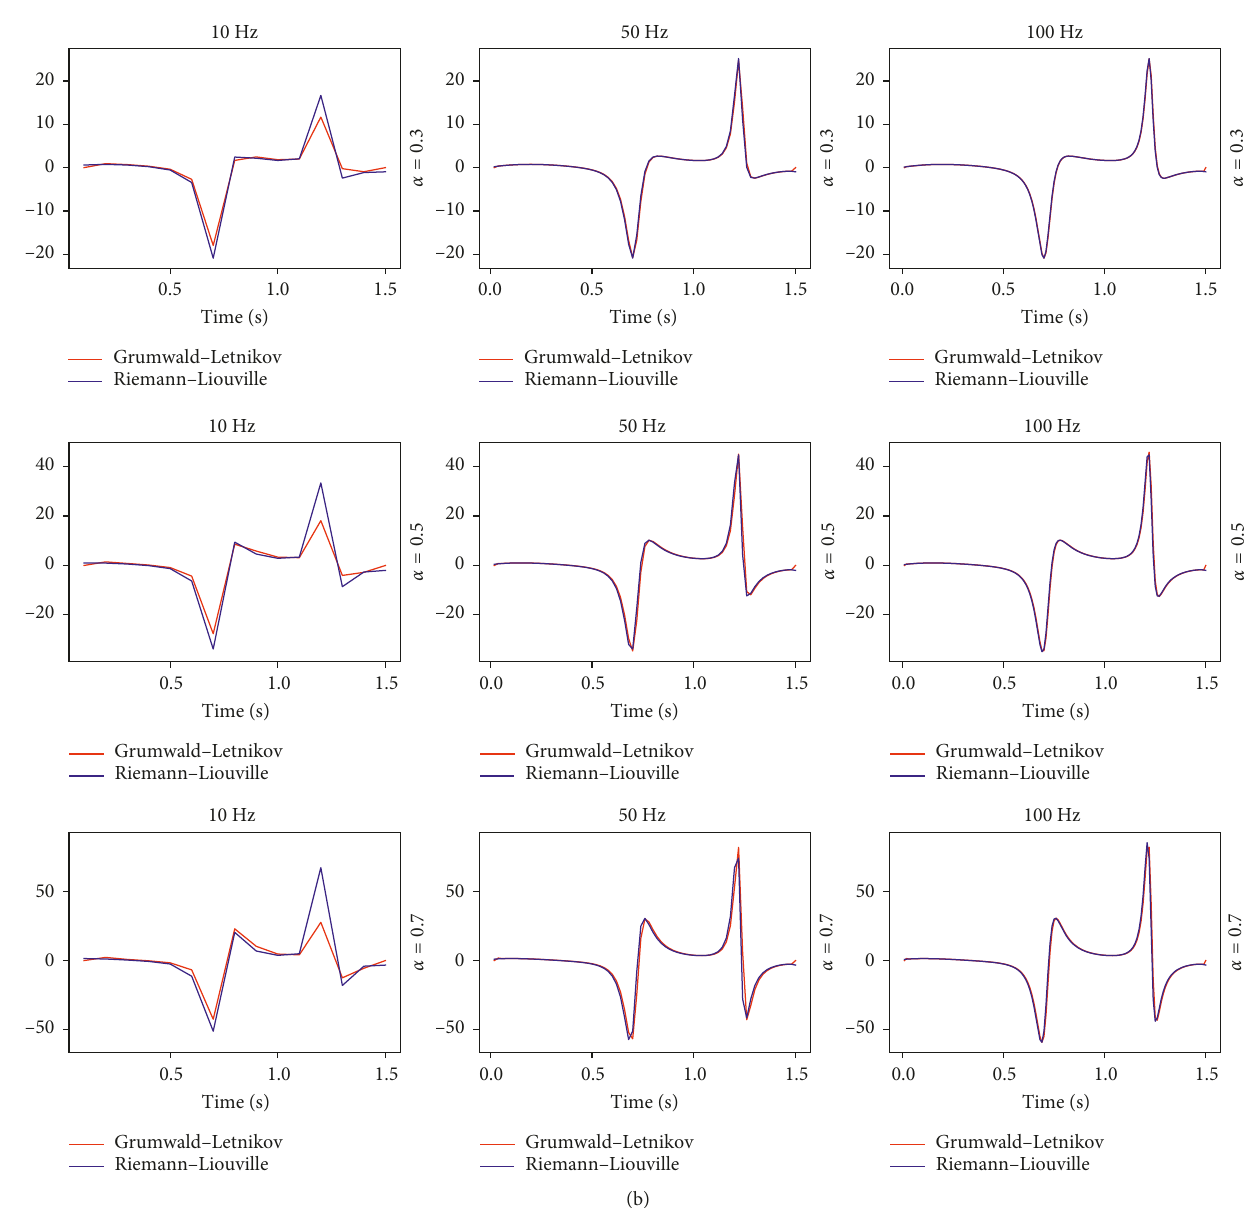
Figure 5: Comparison between fractional derivatives at α of 0.3, 0.5, and 0.7 (top to bottom rows) and for sample rates of 10, 50, and 100Hz (left to right columns) for both (a) and (b) sine-cosine signals. (a) Comparison for oscillator signal. (b) Comparison for sine-cosine signal.